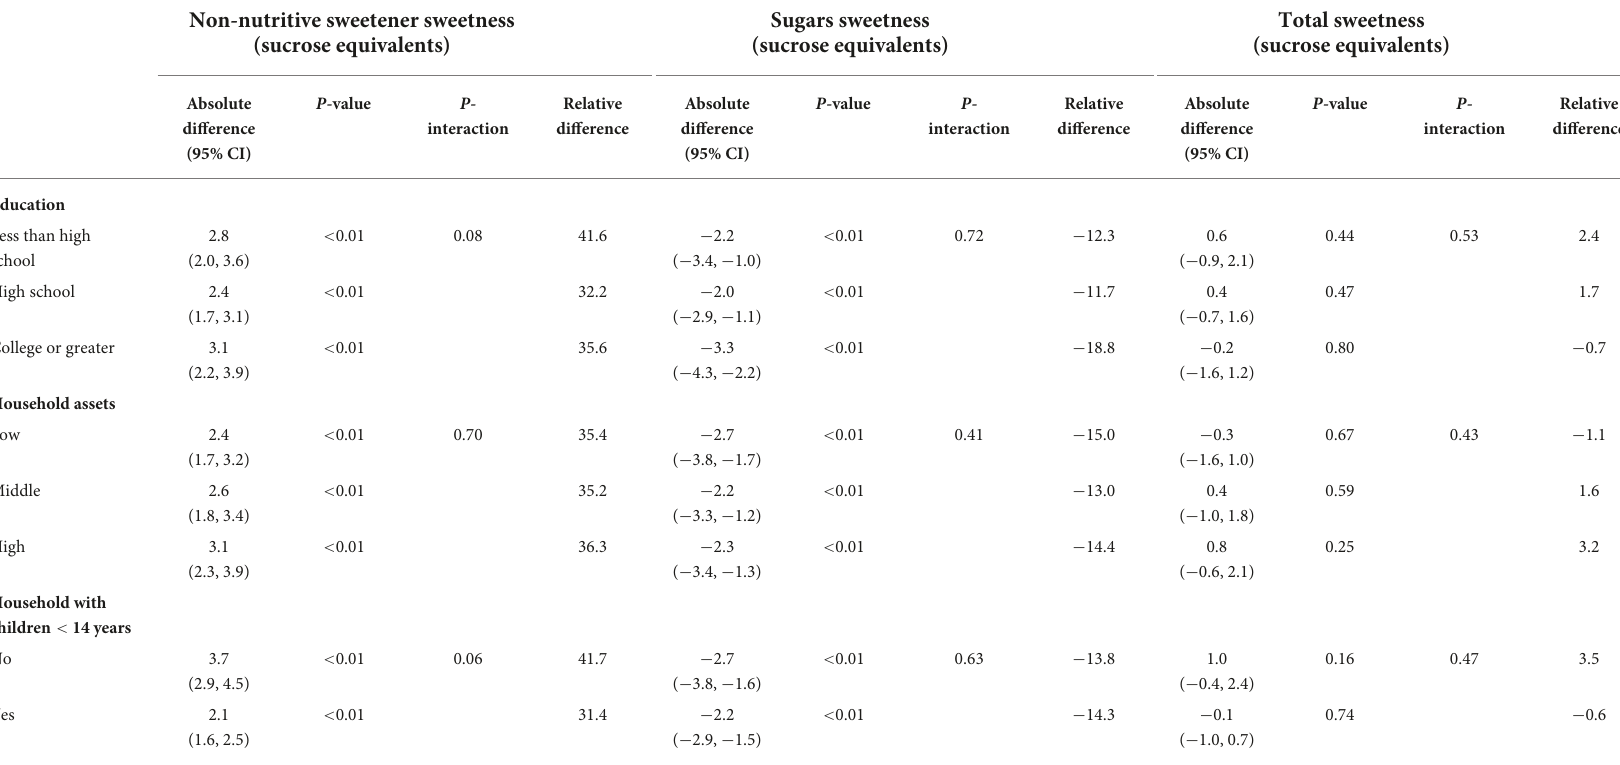
TABLE 3 Mean differences between the estimated adjusted post-policy sweetness purchased from beverages and estimated adjusted counterfactual post-policy purchases by educational level, household assets, and households with or without children under 14